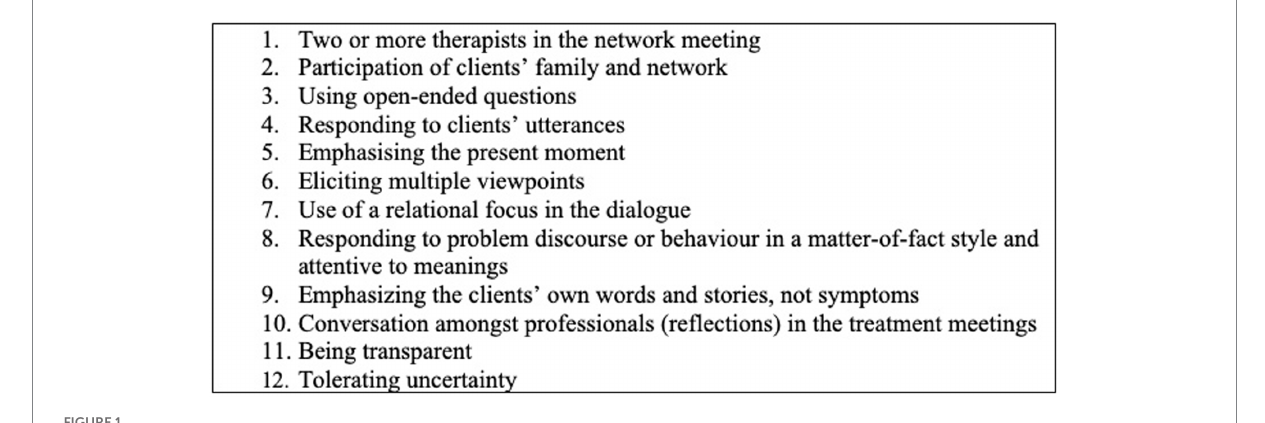
FIGURE 1 Key elements of dialogic paractice (Olson et al.,